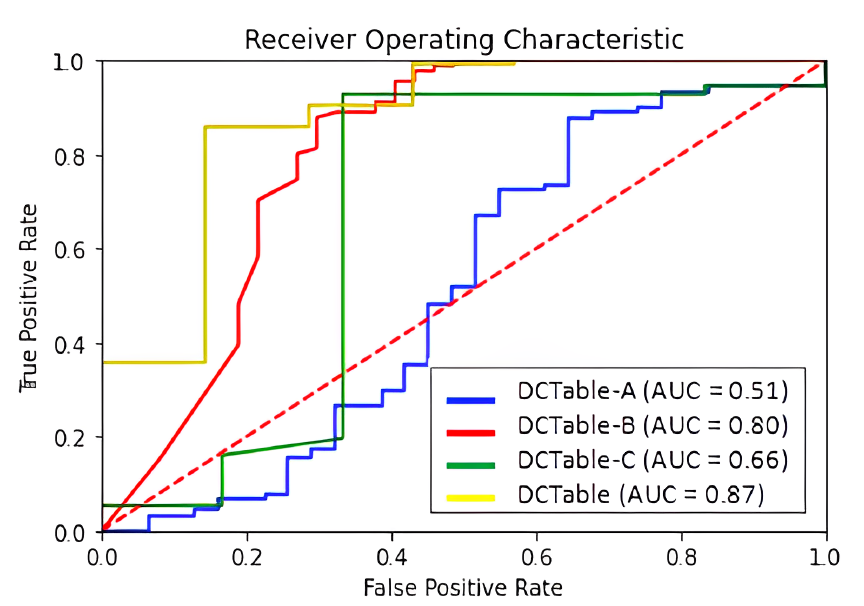
Figure 10. ROC curve for Marmot